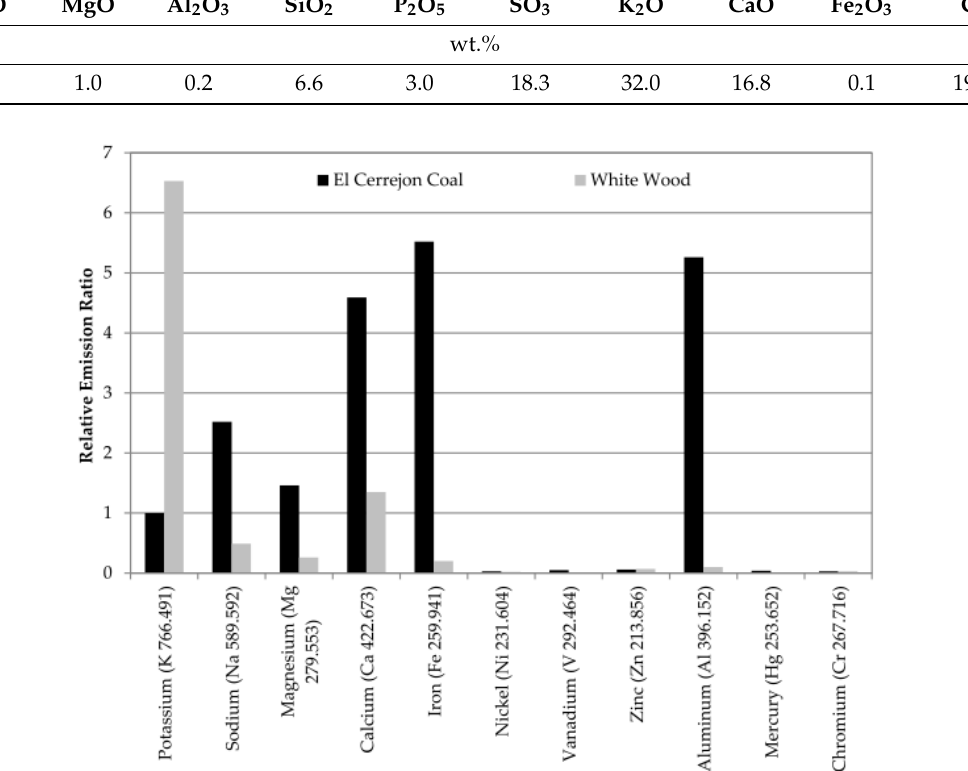
Figure 1. The average relative emission concentration ratios from coal and biomass combustion, compared to the average data for potassium from coal combustion (standardized to 1). Reproduced from Reference [8].